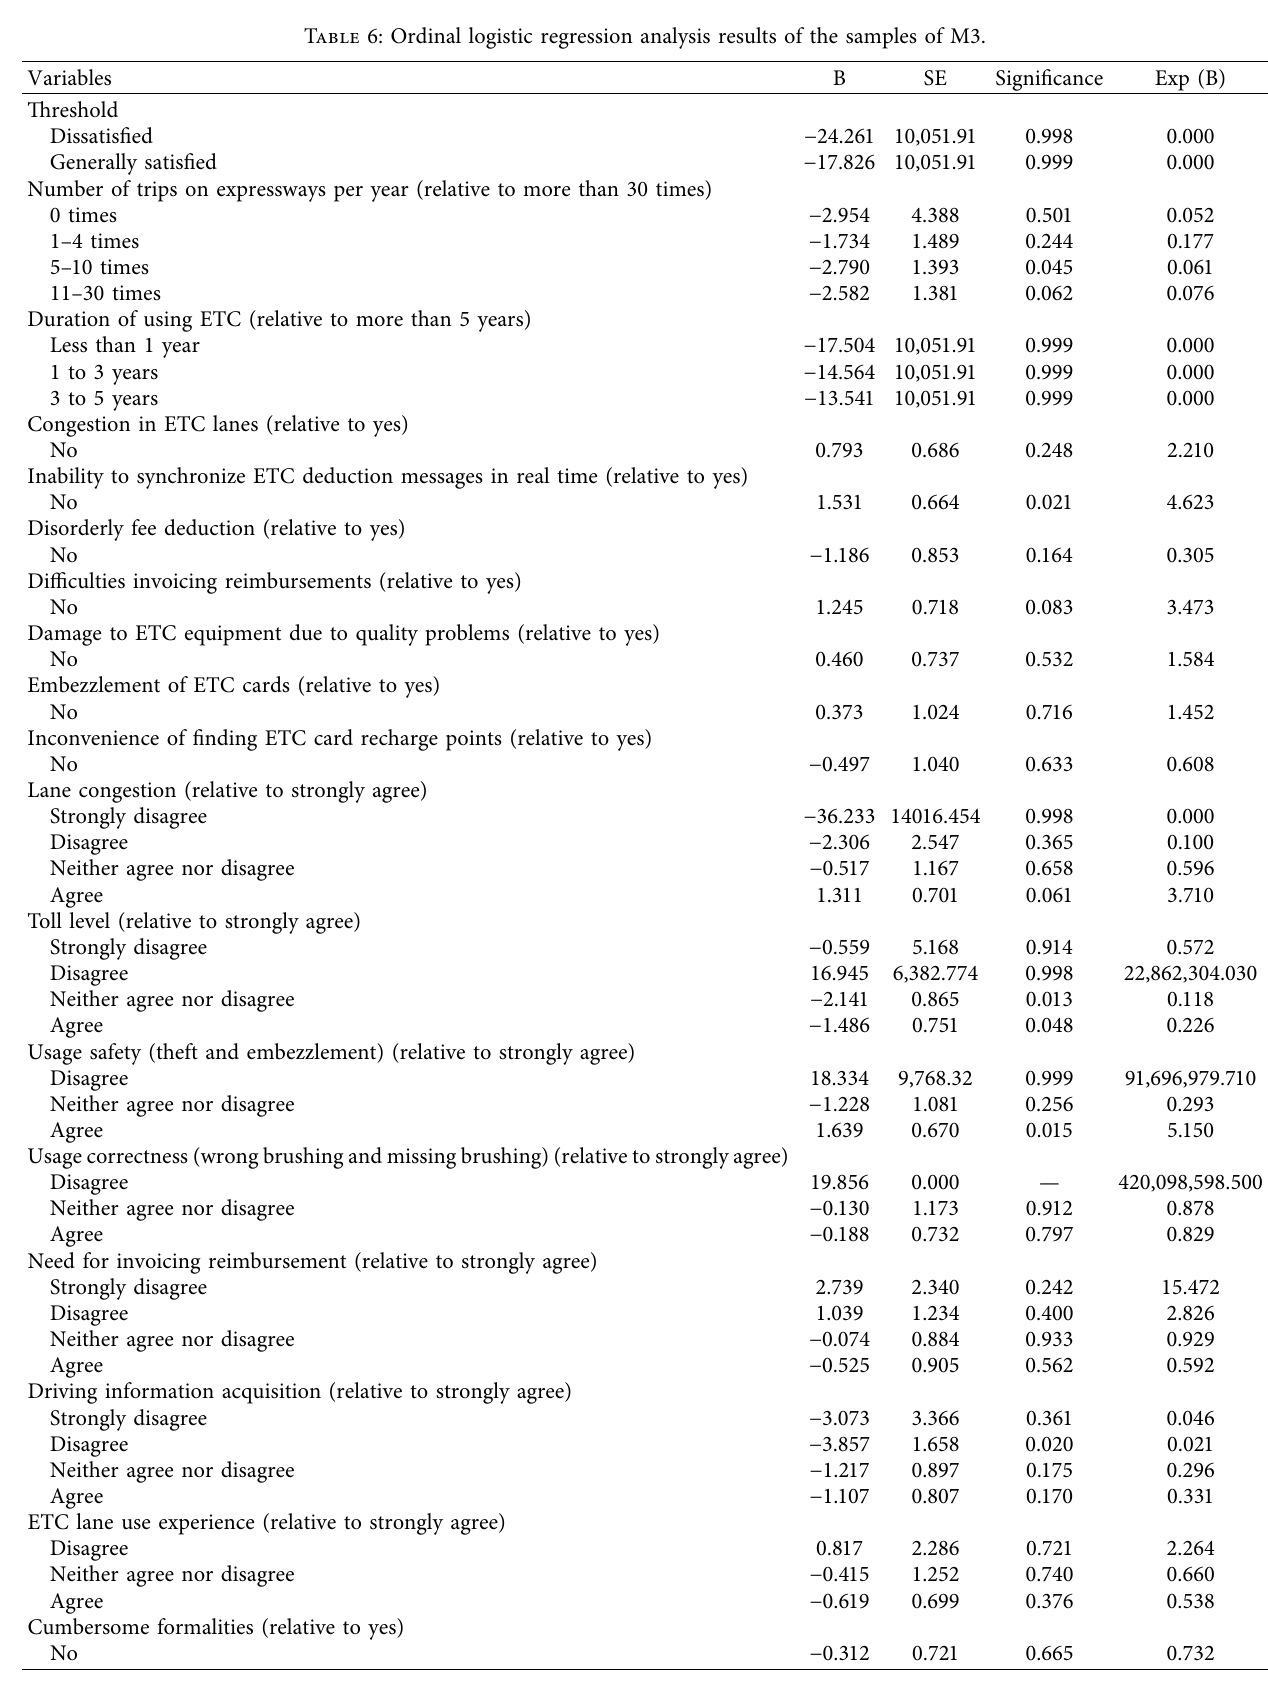
Table 6: Ordinal logistic regression analysis results of the samples of